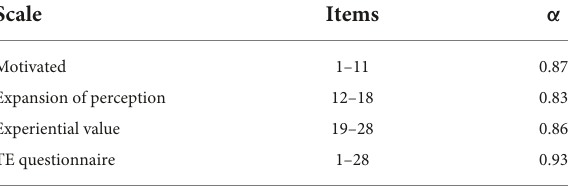
TABLE 1 Reliability analysis of TE questionnaire and its related qualities.